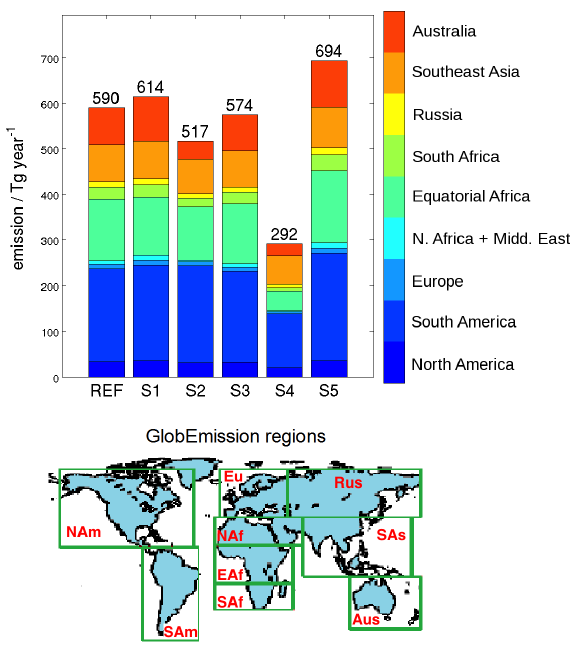
Figure 8. Isoprene emission totals for year 2003 from the reference MEGAN–MACC run and sensitivity runs S1–S5. The absolute con- tributions of nine geographical regions to global total are shown in the top figure. Colours assigned to each region are defined in the colour bar on the right. The extent of GlobEmission regions (Aus –